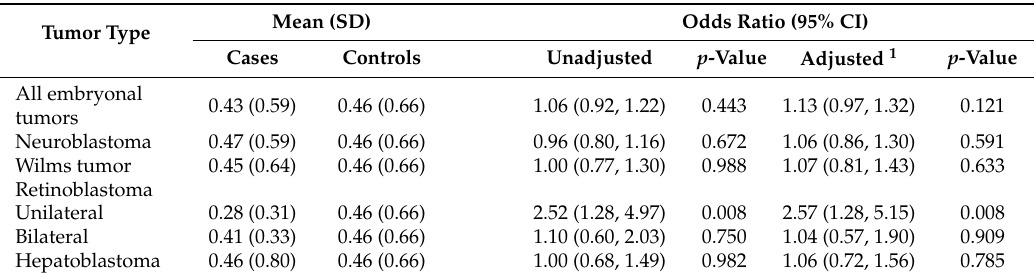
Table 2. Associations between continuous distance (km) of maternal residence to the nearest major roadway and embryonal tumors in offspring.